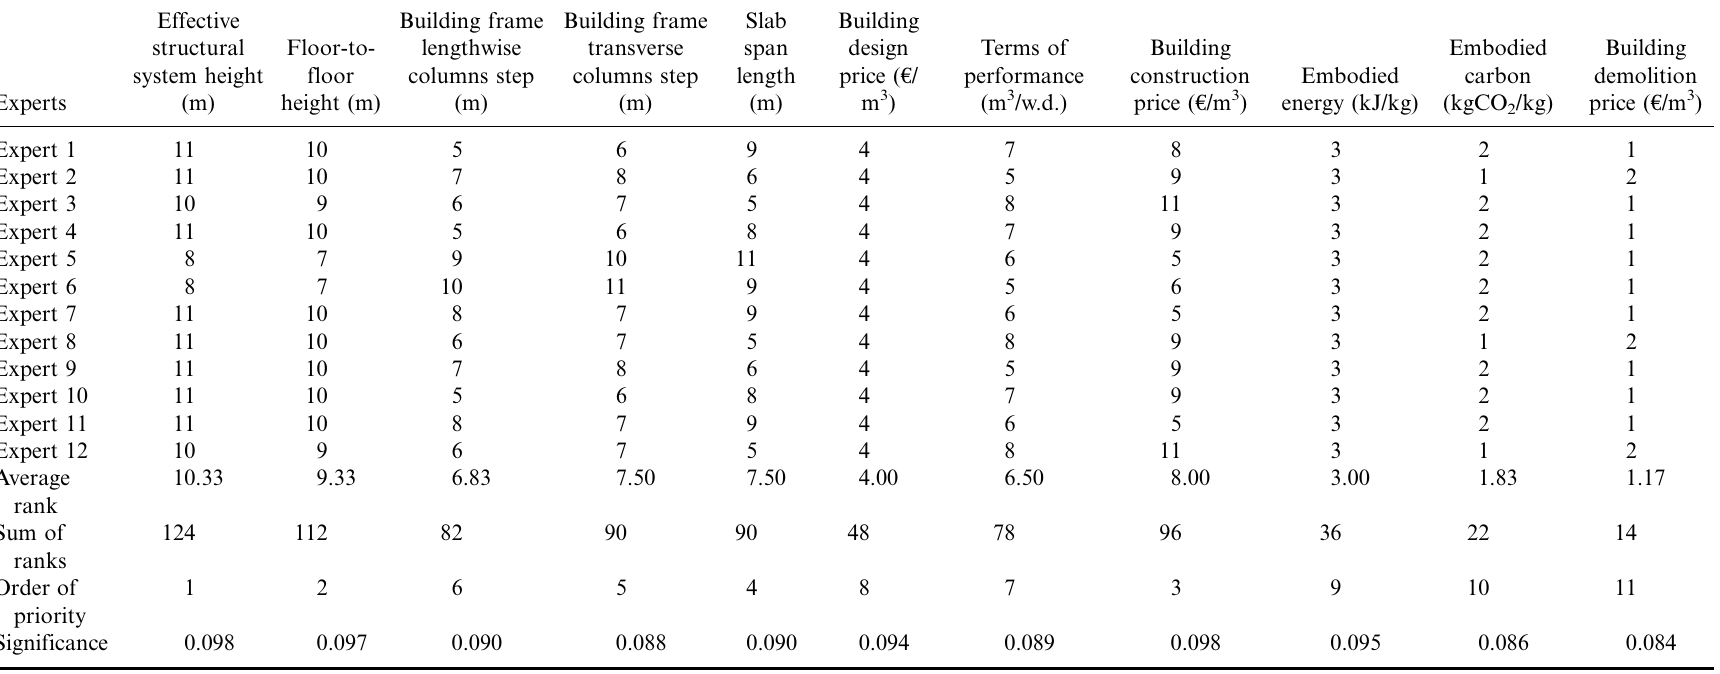
Table 2. Establishment of weight of structural system